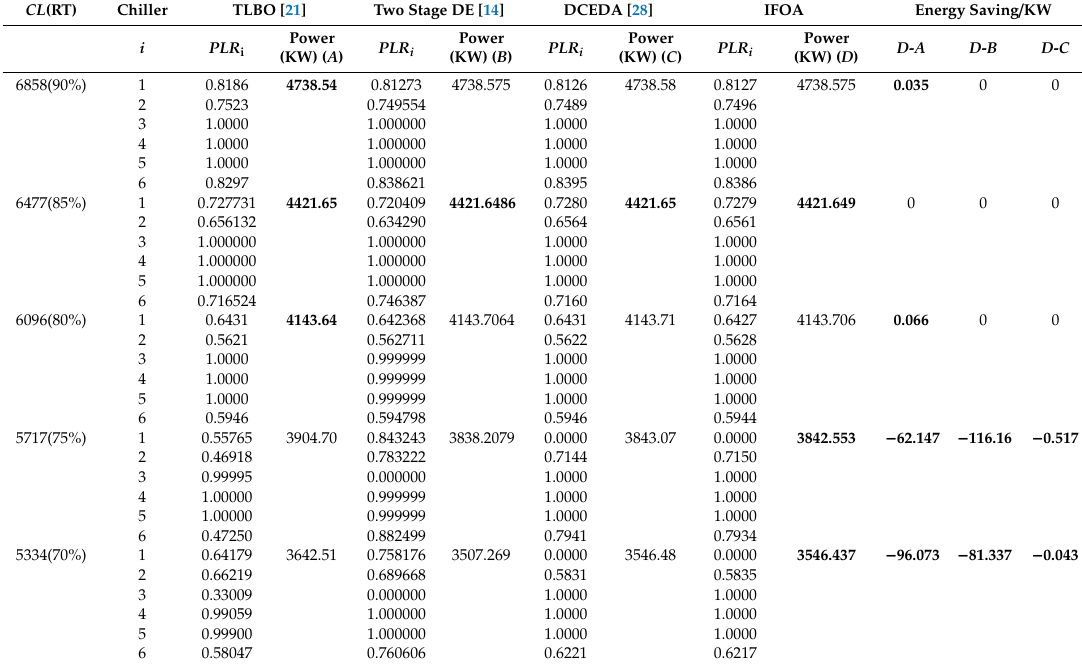
Table 5. The energy conservation of IFOA compared with teaching–learning-based optimization (TLBO), Two Stage di ff erential evolution (DE) and distributed chaotic estimation of distribution algorithm (DCEDA) in case